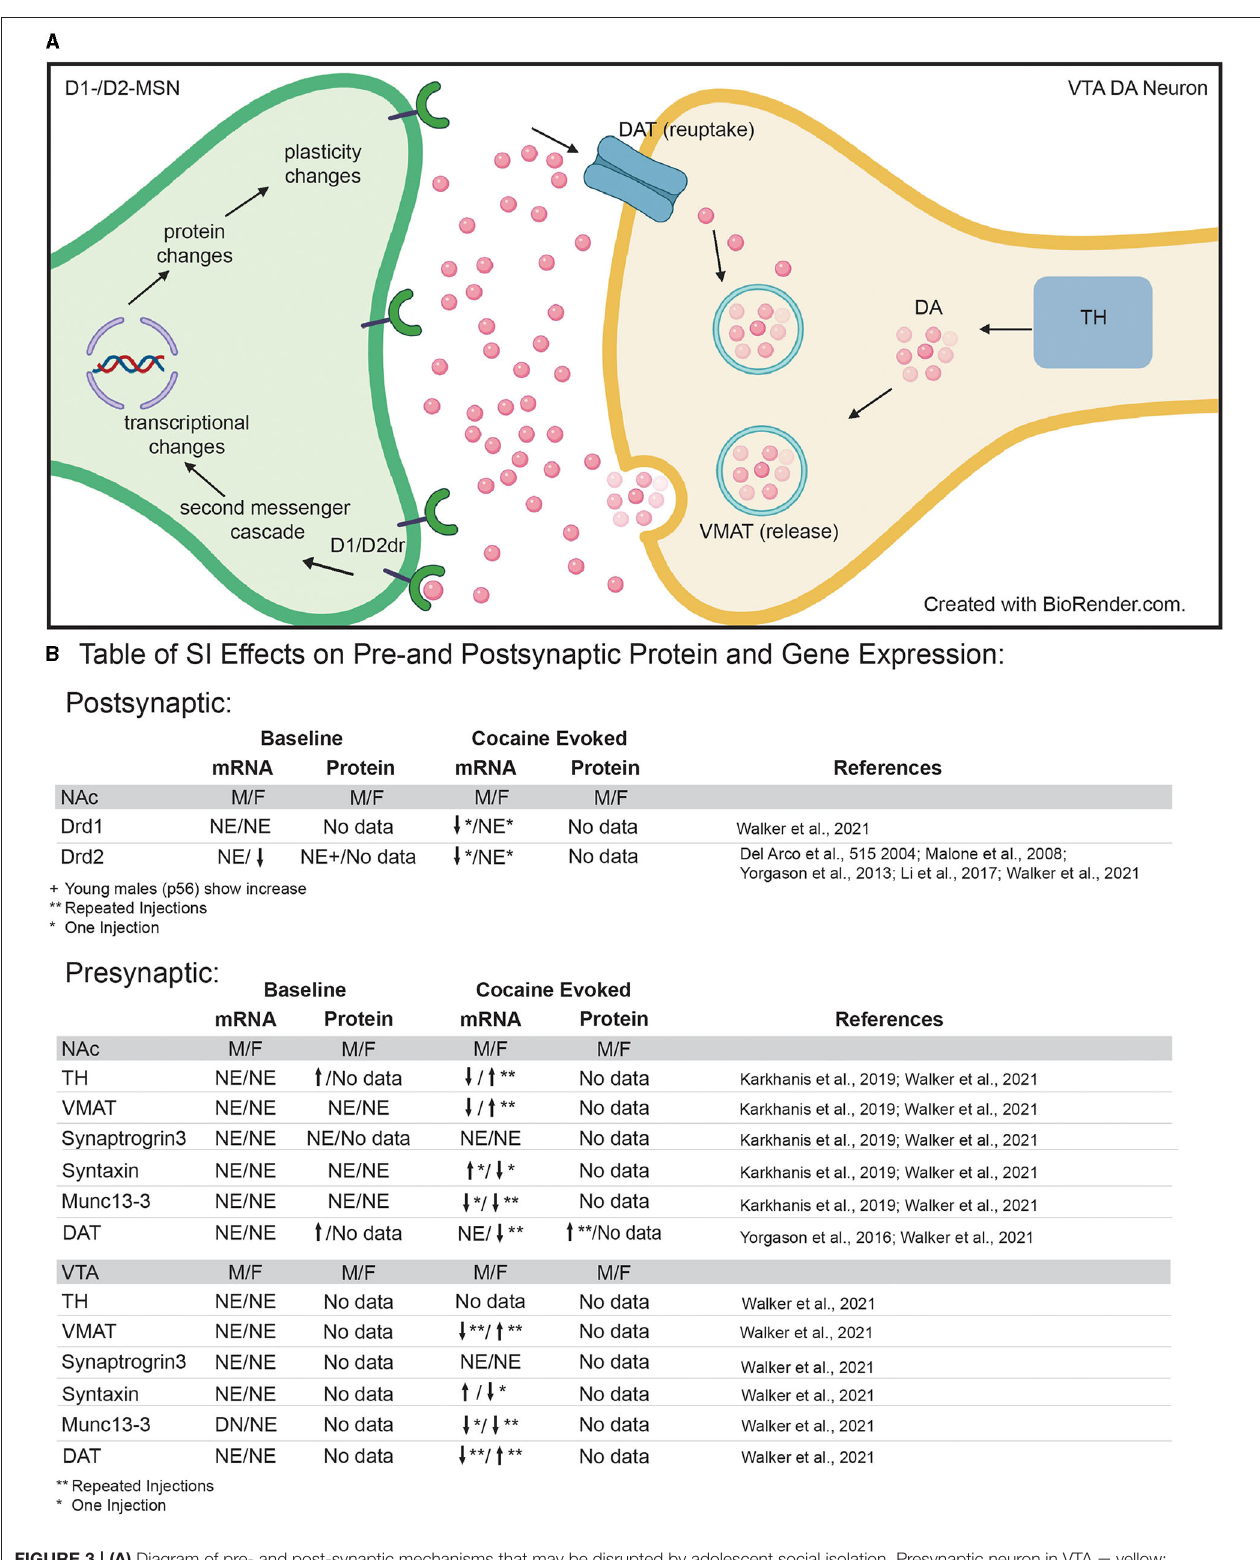
FIGURE 3 | (A) Diagram of pre- and post-synaptic mechanisms that may be disrupted by adolescent social isolation. Presynaptic neuron in VTA = yellow; post-synaptic neuron in NAc = green. (B) Table of pre- and post-synaptic effects of adolescent social isolation on genes and proteins associated with